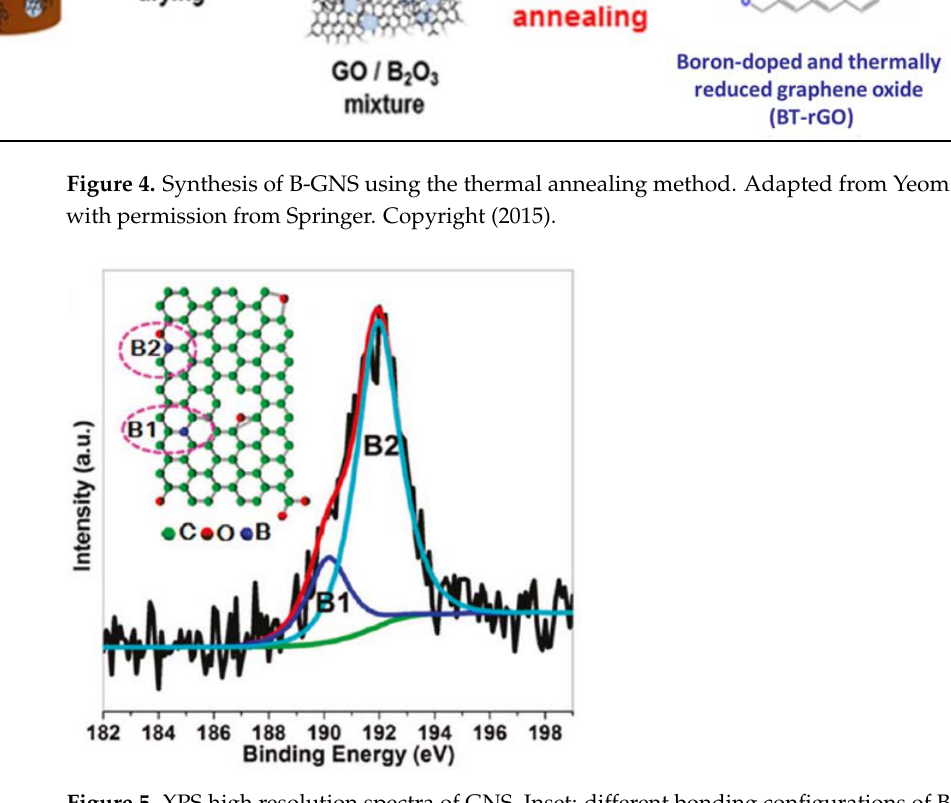
Figure 5. XPS high resolution spectra of GNS. Inset: different bonding configurations of B, BC 3 (B1), and BC 2 O (B2). Adapted from Wu et al. [104], with permission from the American Chemical Society. Copyright